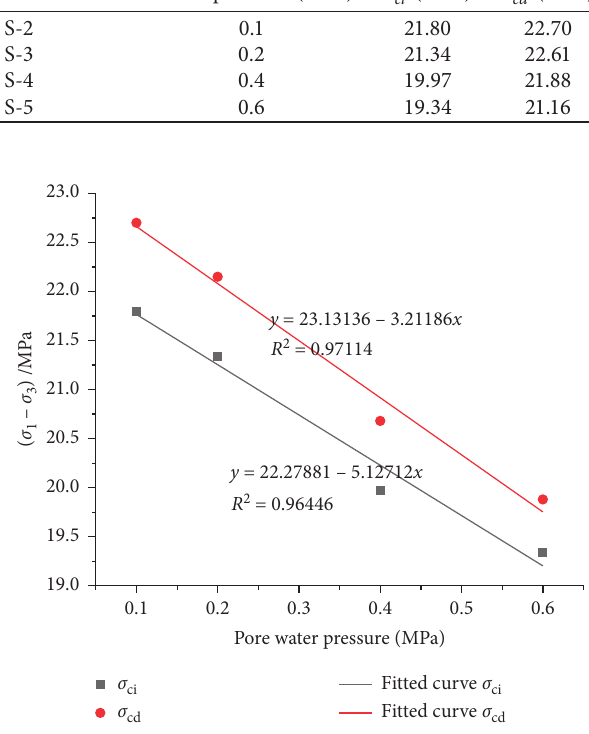
Figure 7: Strength characteristics of unloading seepage.